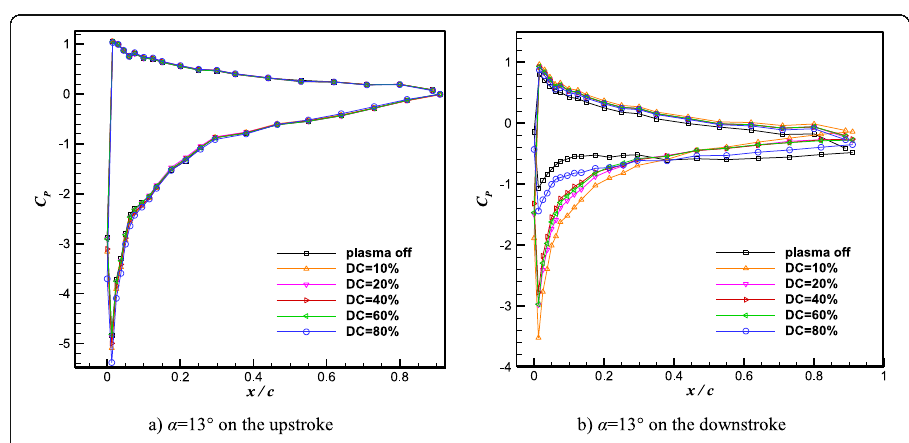
Fig. 7 The effect of duty cycle on the pressure coefficient of α =